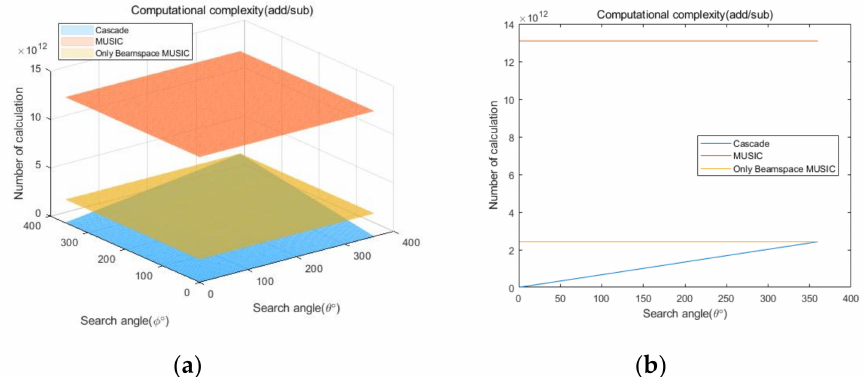
Figure 26. Curves for comparing addition / subtraction computational complexities of the proposed cascade algorithm, the general MUSIC algorithm, and only Beamspace MUSIC, according to the search range: ( a ) 3D, ( b ) side